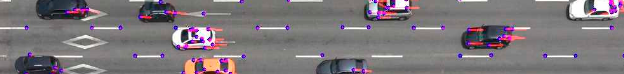
Figure 16. A description of the background subtraction methodology .